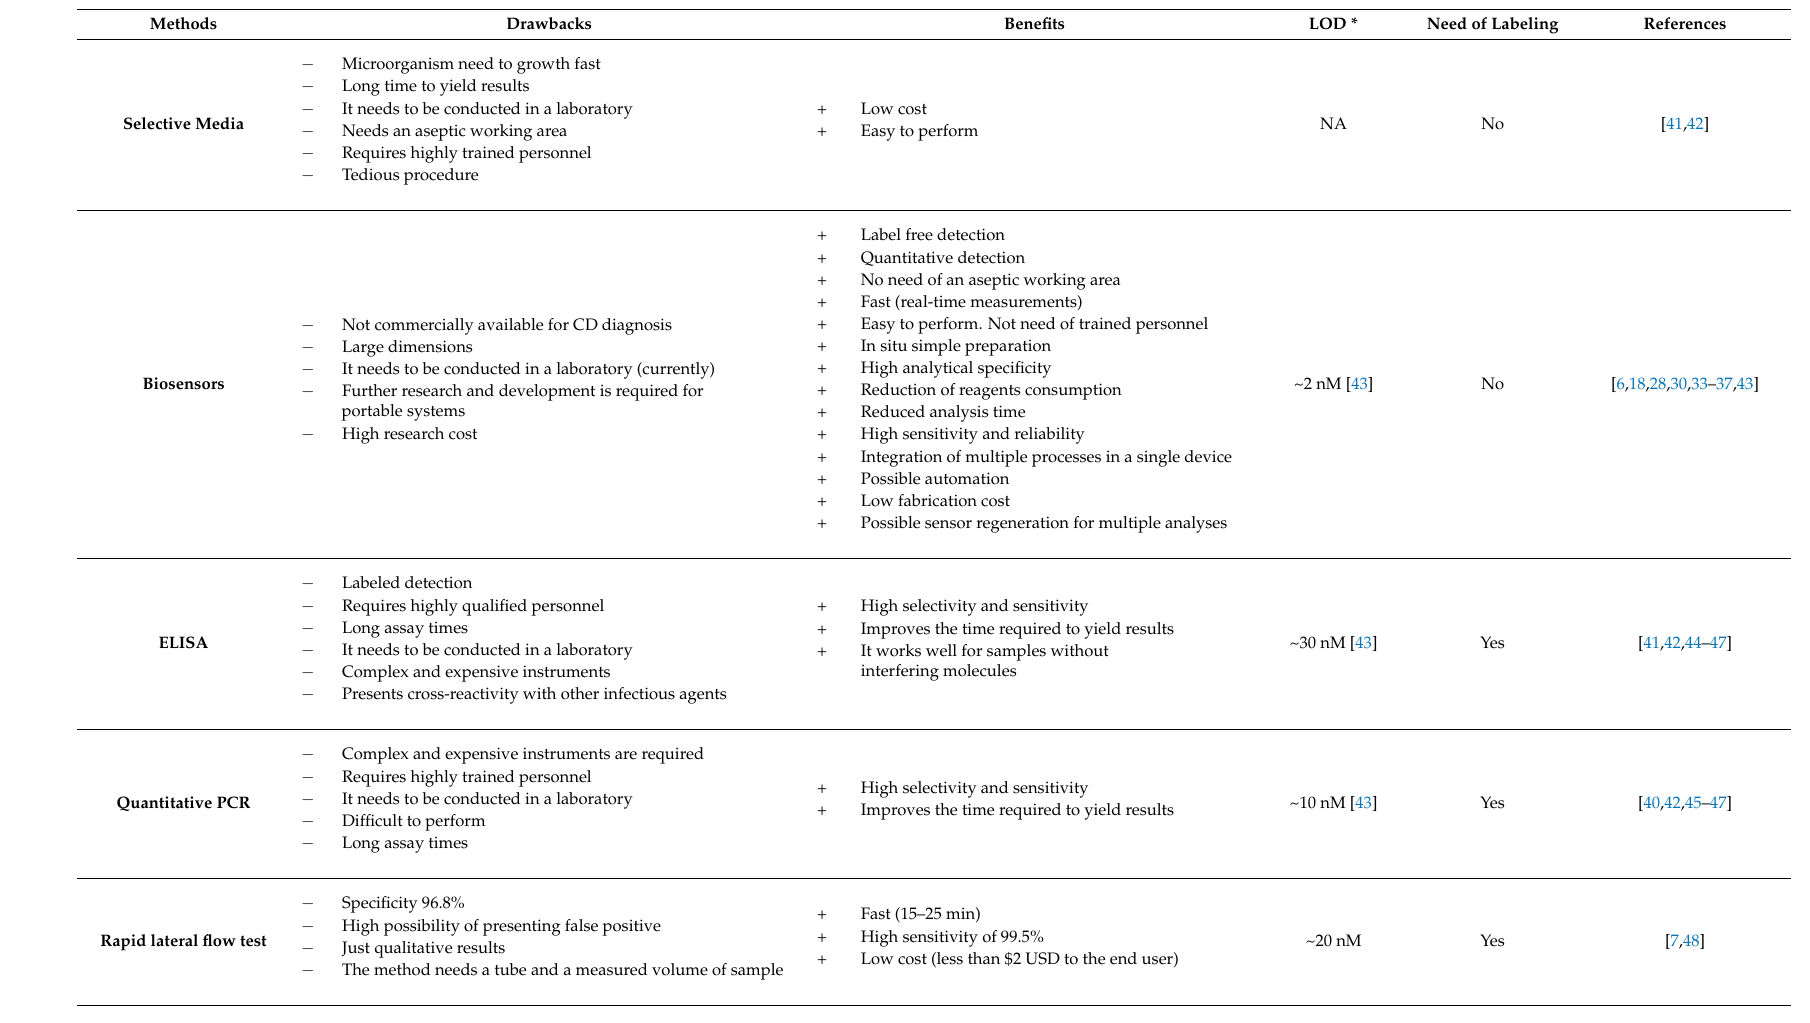
Table 1. Methods for the diagnosis of Chagas disease (CD). * LOD: Limit of Detection. NA: Not